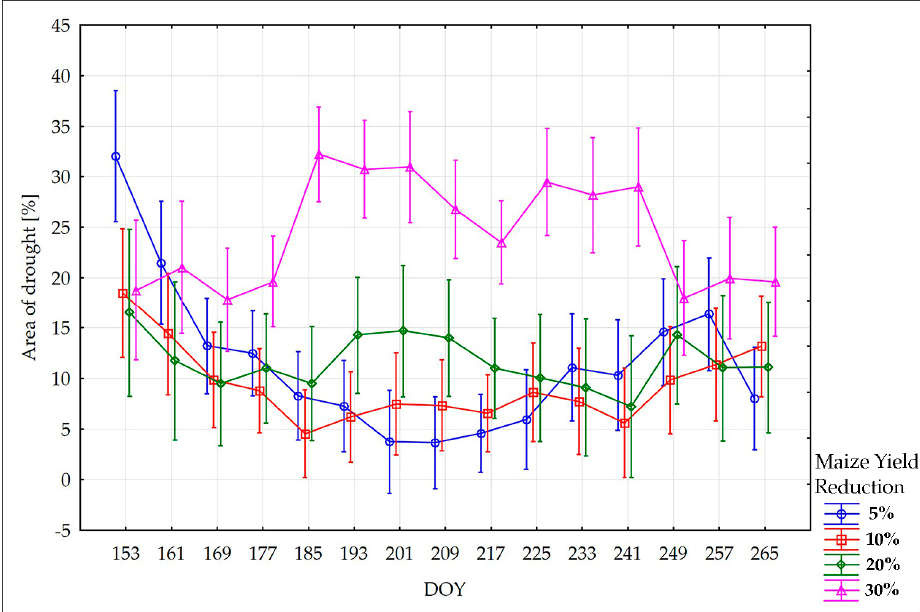
Figure 13. Multi-way ANOVA in groups of yield reduction for maize.